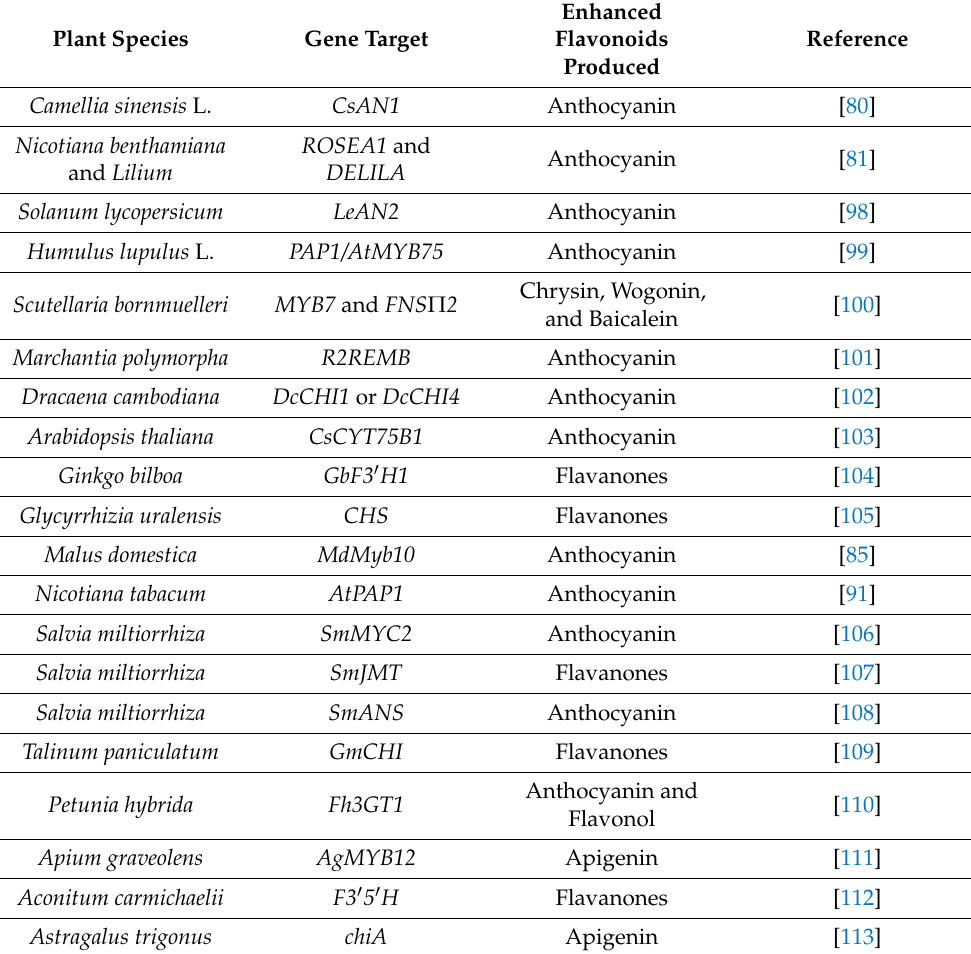
Table 2. Flavonoid production using metabolic engineering approaches in various plant species.